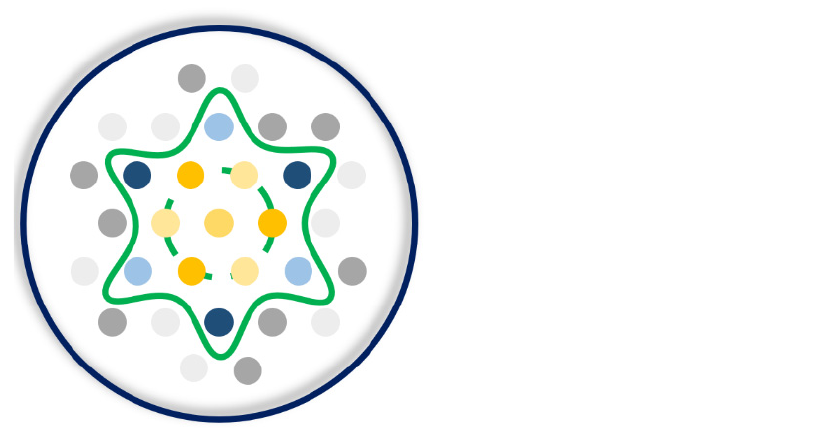
Figure 4. Sketch map of flow rate change in Scheme 5. The dark color indicates large flow rate, while the light color indicates small flow rate. Table 3. Settings for Schemes 5 and 6.